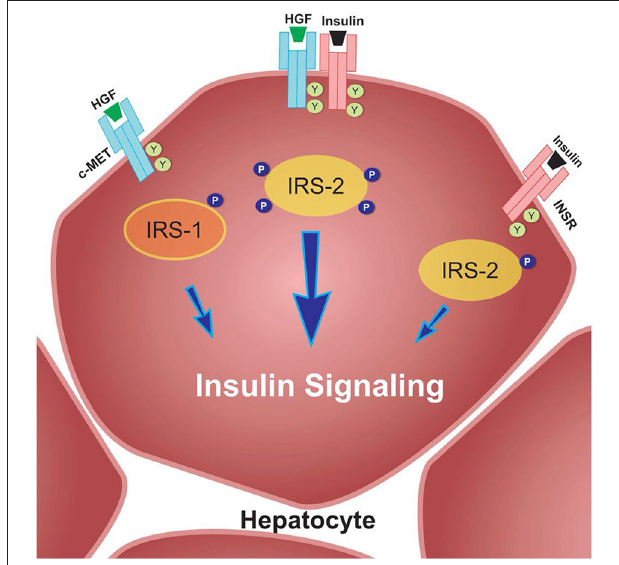
FIGURE 2 | c-Met/INSR crosstalk in hepatocytes. The c-Met/INSR complex increases the recruitment of IRS-1 and 2 and thereby amplifies the insulin signaling pathway in hepatocytes. Adapted from Fafalios et al.